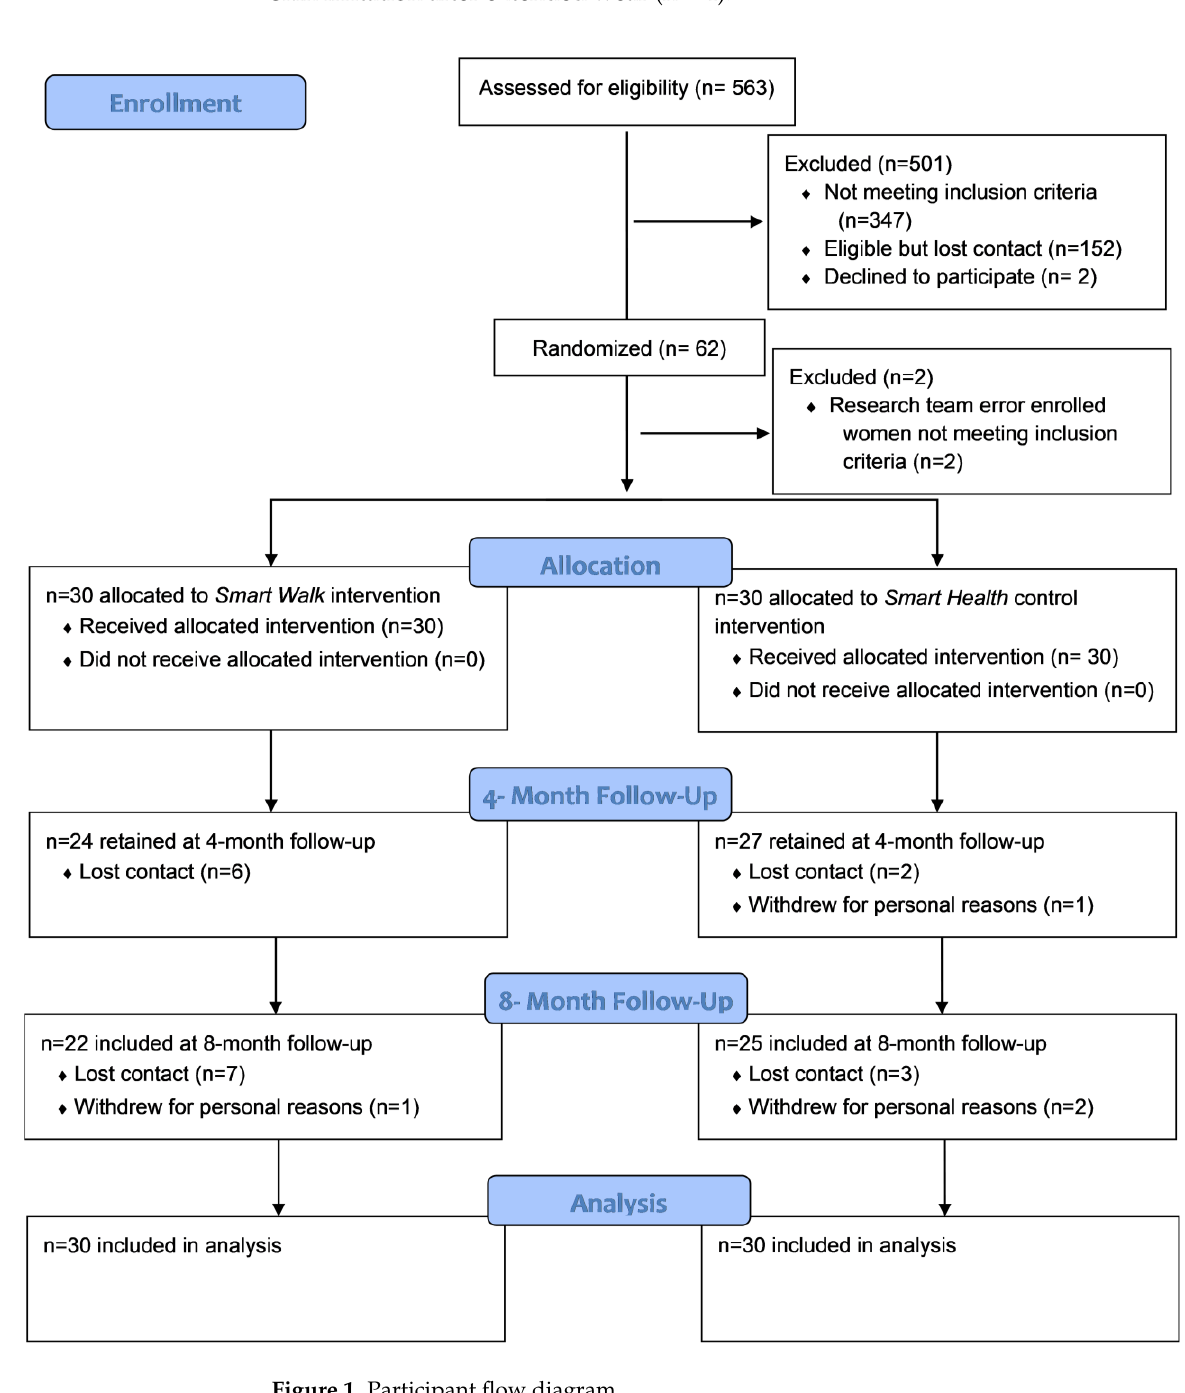
Figure 1. Participant flow diagram.